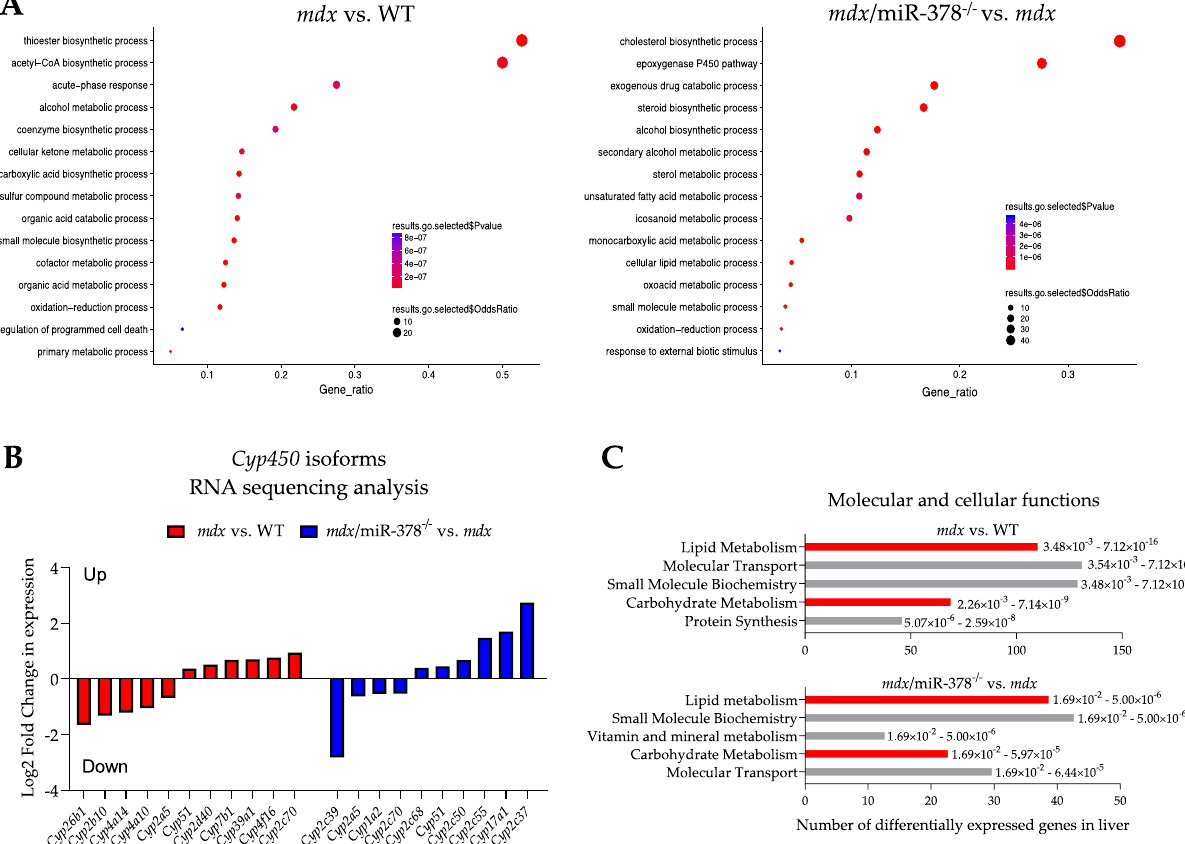
Figure 3. Metabolic pathways are predominantly changed in the livers of both mdx and mdx /miR-378 −/− mice. ( A ) Analysis of gene ontology (GO) terms of affected pathways. ( B ) The graph showing higher and lower expression of cytochrome P450 (CYP450) isoforms based on RNA-seq results, presented as the fold change. ( C ) Affected pathways associated with molecular and cellular functions were determined by ingenuity pathway analysis (IPA) and arranged according to the p -value